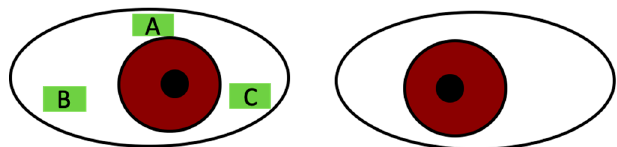
Figure 8. Areas of impression cytology: ( A ) superior bulbar conjunctiva for RT-PCR of MUC5AC and MUC16, ( B ) inferior temporal bulbar conjunctiva for MUC16 immunohistochemistry, and ( C ) inferior nasal bulbar conjunctiva for MUC5AC PAS stain.